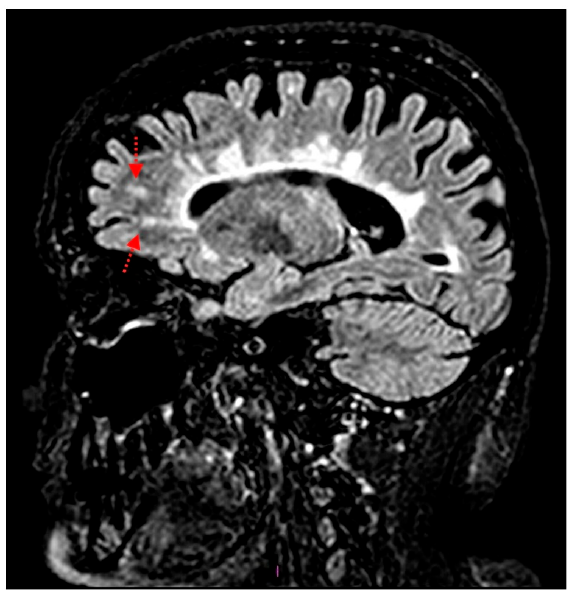
Figure 2. Magnetic resonance imaging on the sagittal fluid attenuated inversion recovery (FLAIR) sequence of the brain, demonstrating the two demyelinating subcortical left frontal lesions (red arrows), resulting from the enhancing ones at the disease onset.